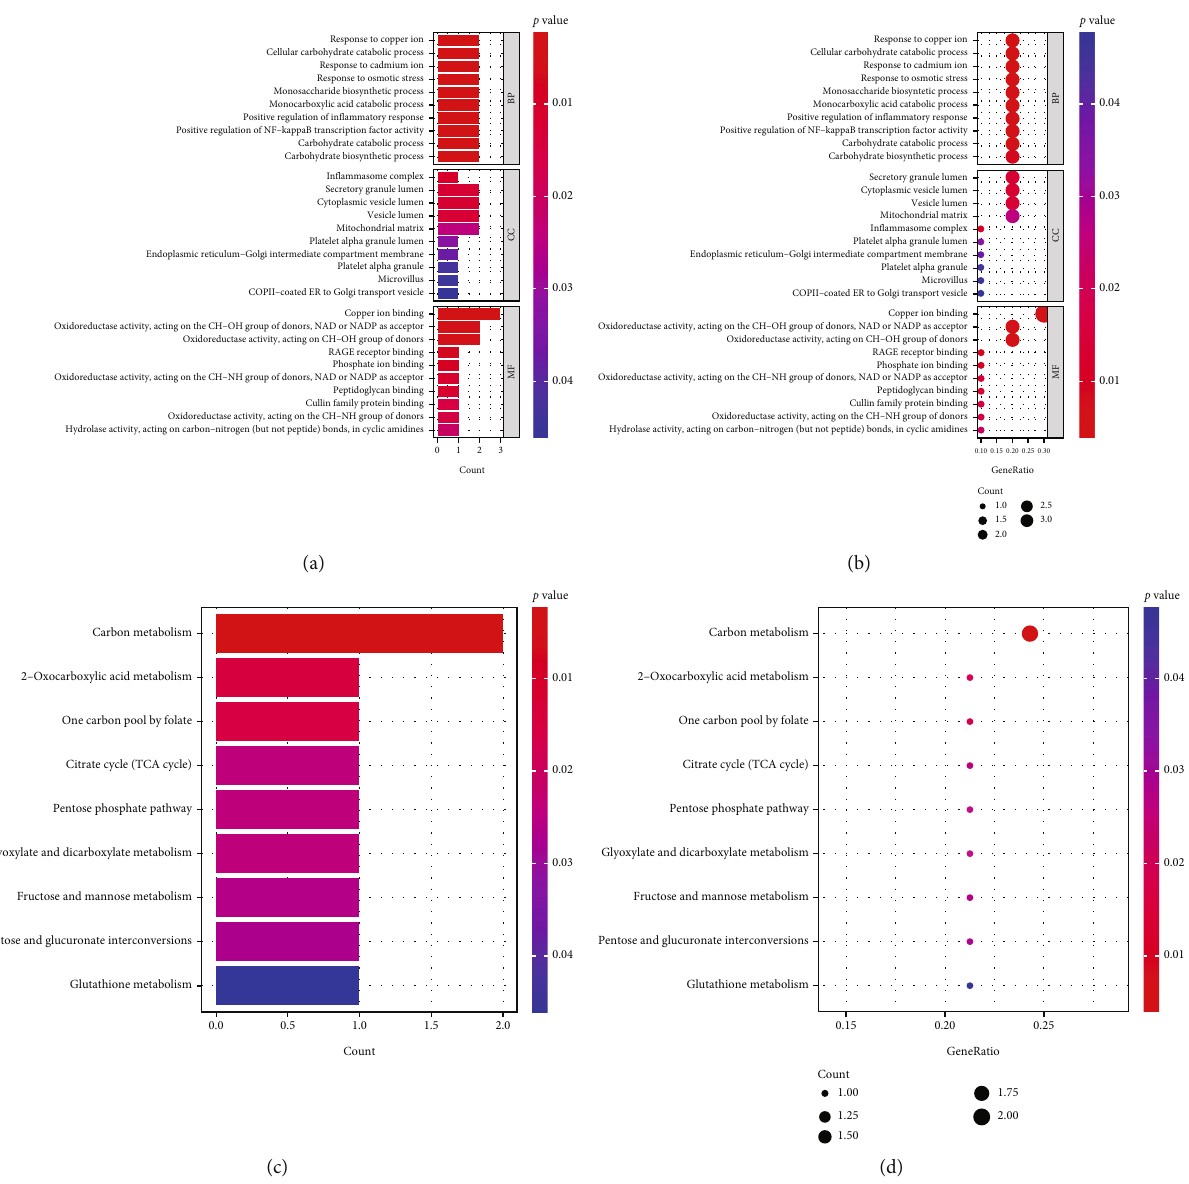
Figure 2: Functional enrichment analyses of the 10 DE-CRGs. (a, b) Bar plot and bubble plot of GO enrichment analysis of DE-CRGs. Top 10 GO terms enrichment in biological process (BP), cell composition (CC), and molecular function (MF). (c, d) Bar plot and bubble plot of KEGG enrichment analysis of DE-CRGs. The bar color indicates the enrichment level of DE-CRGs. Bubble size represents the number of enriched DE-CRGs, and bubble color represents the enrichment signi fi cance of DE-CRGs. p < 0 : 05 and q < 0 : 05 were considered signi fi cantly